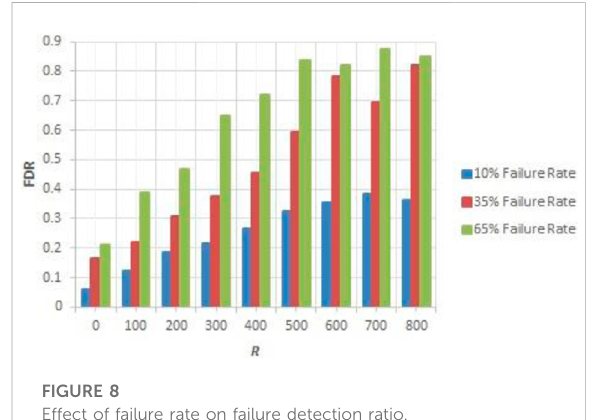
FIGURE 9 Effect of failure rate on failure recovery ratio.